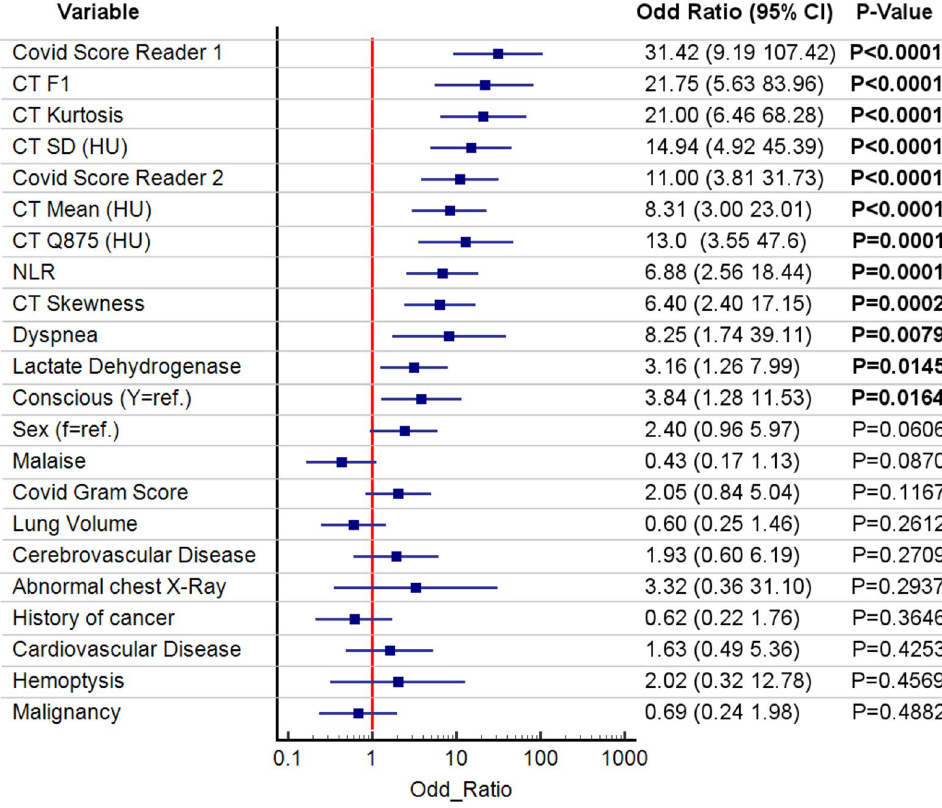
Figure 2. Odd ratios with 95% confidence intervals for critically ill outcome. The continuous variables are split into two groups below / above their median value. Significant P values (P < 0.05) are bold. Variables with P values > 0.5 are not shown. Notice that 6/10 of the highest ranked predictors are lung CT density quantitative